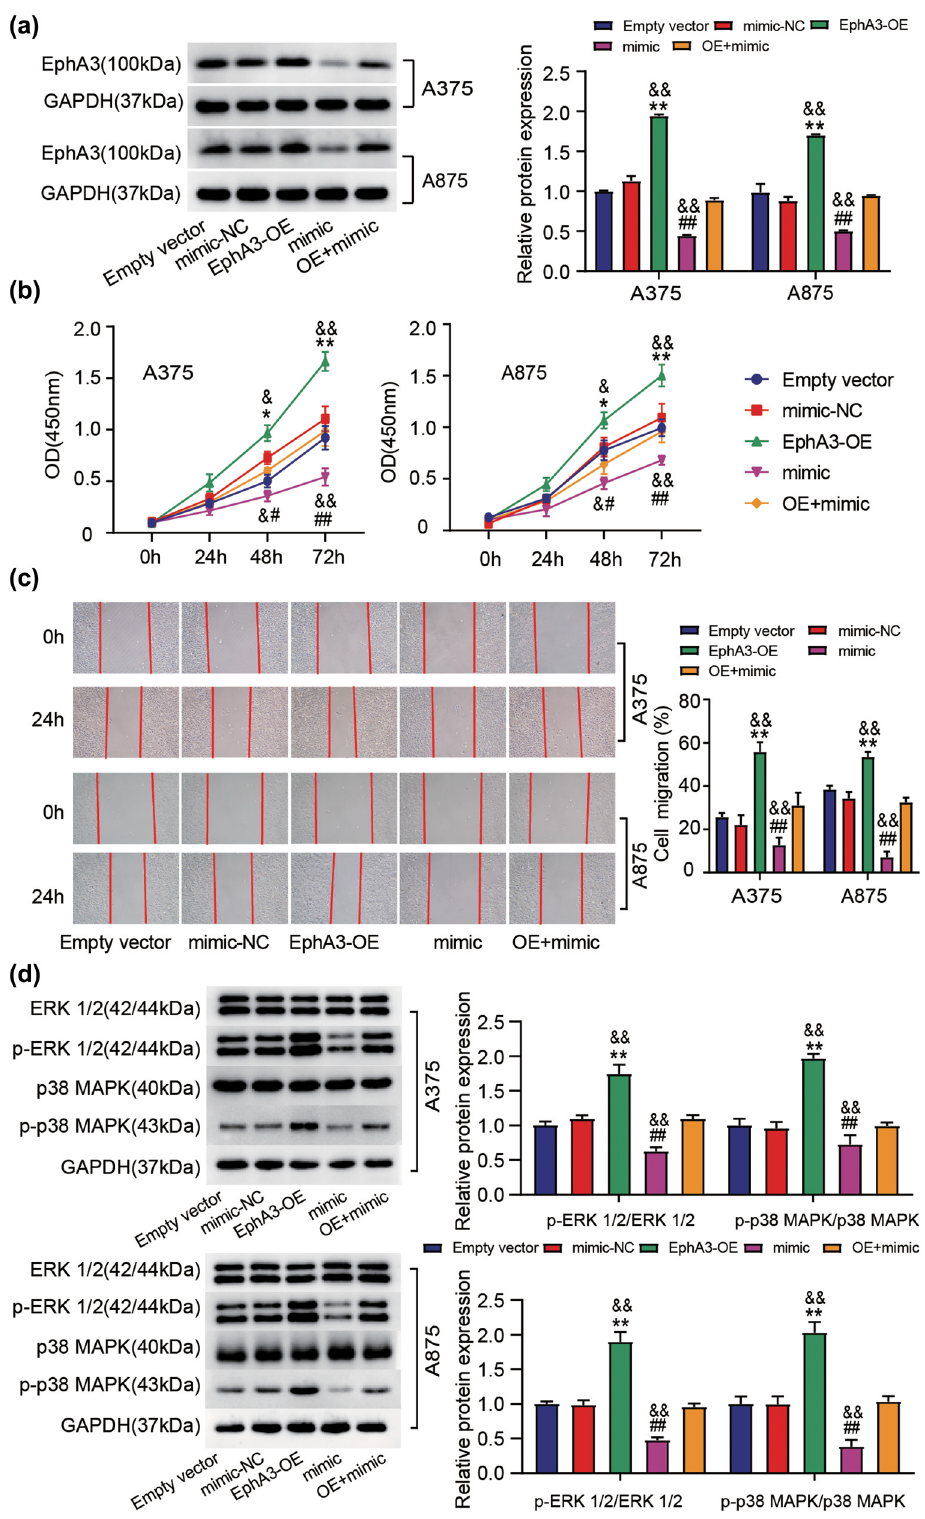
Figure 5: MiR - 3666 overexpression abrogates the EphA3 - driven proliferation and migration in melanoma cells through MAPK/ERK signaling pathway. Empty vectors, EphA3 overexpressing vectors ( EphA3 - OE ) , miR - 3666 mimic ( mimic ) , mimic NC, and EphA3 - OE + mimic were introduced into A375 and A875 cells. After 48 h transfection, ( a ) Western blot analysis of EphA3 expression in these above transfected cells. ( b ) Proliferation in these above transfected cells was determined by CCK - 8 assay. ( c ) Migration in these above transfected cells was assessed by scratch wound assays. ( d ) Western blot analysis of ERK1/2, p - ERK1/2, p38MAPK, and p - p38MAPK expressions in these above transfected cells. * P < 0.05, ** P < 0.01 vs empty vector; # P < 0.05, ## P < 0.01 vs mimic NC; & P < 0.05, && P < 0.01 vs OE + mimic. OE + mimic: EphA3 - OE +